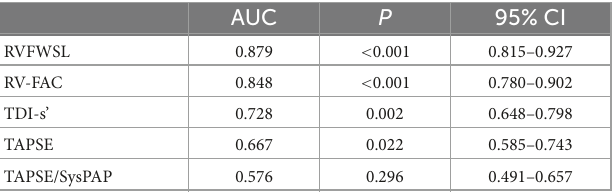
TABLE 4 The ROC curve of RV parameters to predict LCOS.